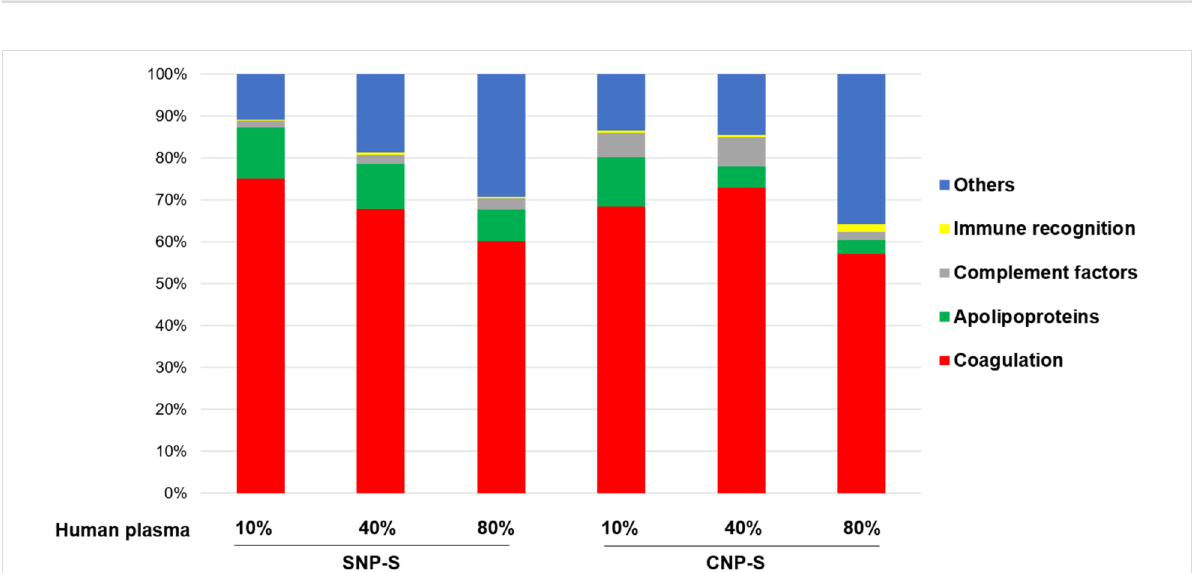
Figure 7: Classification of the human plasma corona proteins identified on small silica (SNP-S) and carbon (CNP-S) nanoparticles according to their biological functions. The LFQ intensity is used to calculate the percentages of protein groups.